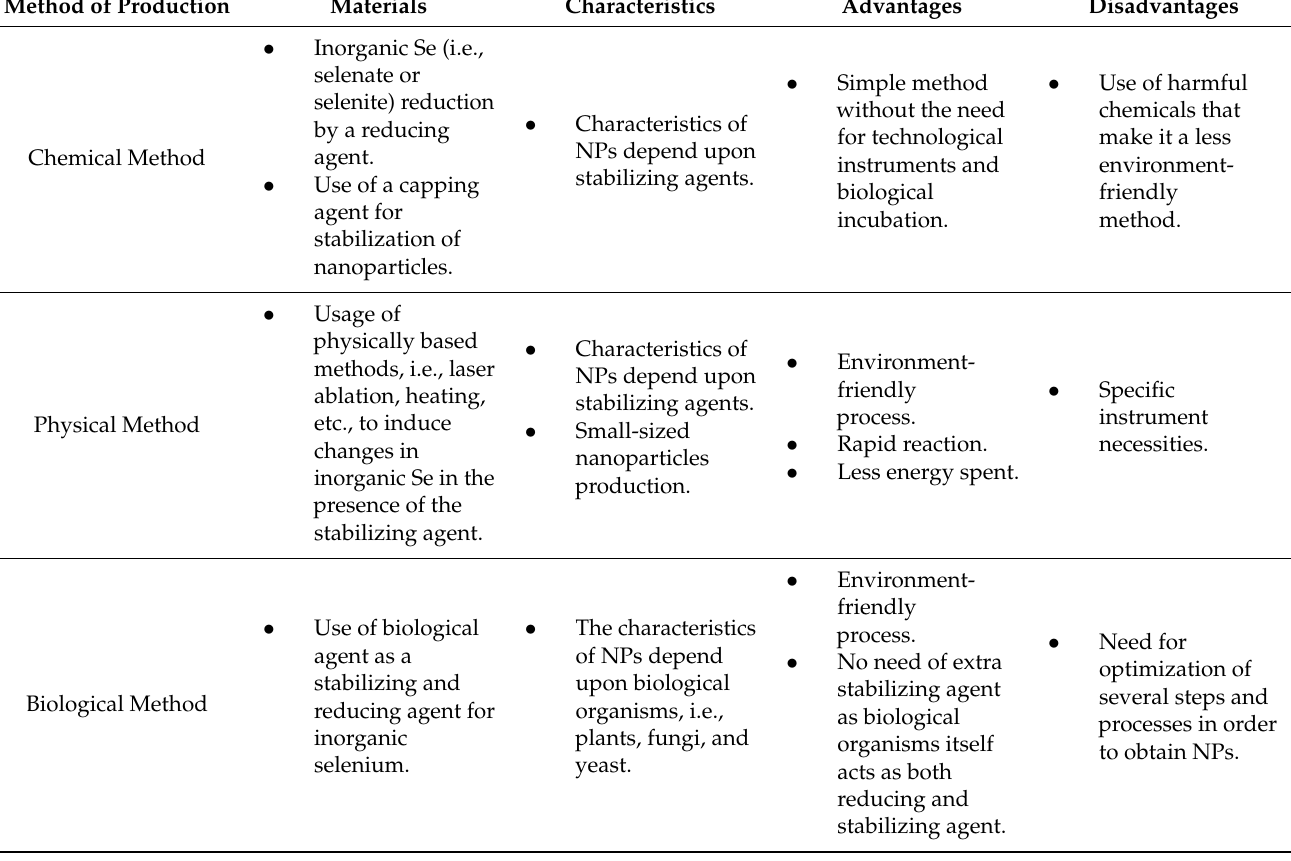
Table 2. Comparative evaluation of SeNPs production